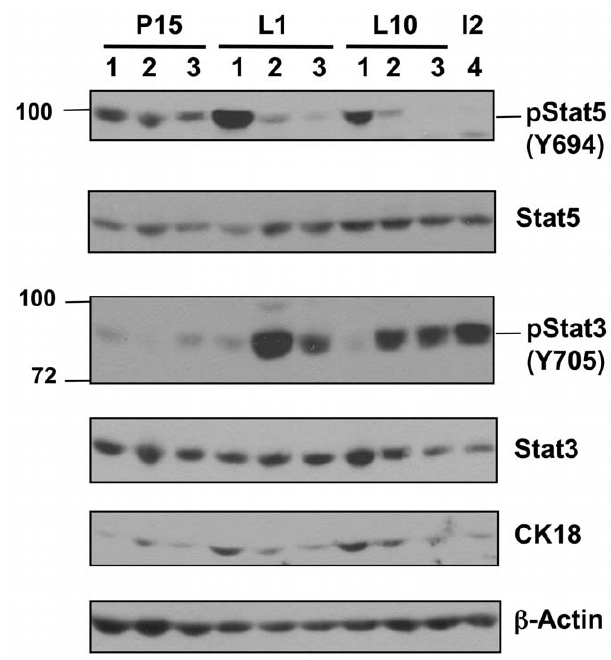
Figure 3. Changes in the activation of Stat5 and Stat3 in mammary glands from mice expressing the MMTV-Cre trans- gene during late pregnancy and early lactation. The number 4 mammary glands from Shp1 fl/ + (control) (lane 1), Shp1 fl/ + ;MMTV-Cre (lane 2), and MMTV-Cre (lane 3) mice at pregnancy day 15 (P15), lactation day 1 (L1), day 10 (L10), and from wild type FVB mice at involution day 2 (I2) (lane 4) were isolated and whole tissue lysates prepared as described in the Materials and Methods. Equal amount of proteins ( , 40 m g) from each sample were resolved by gel electropho- resis, and immunoblotted with antibodies against phospho-Stat5 (p-Stat5; Y694), or phospho-Stat3 (p-Stat3; Y705). The immunoblots were reprobed with antibodies against Stat5, Stat3, and cytokeratin-18 (CK-18), and beta-actin to demonstrate equal loading. Similar results were seen from at least two different mice for each